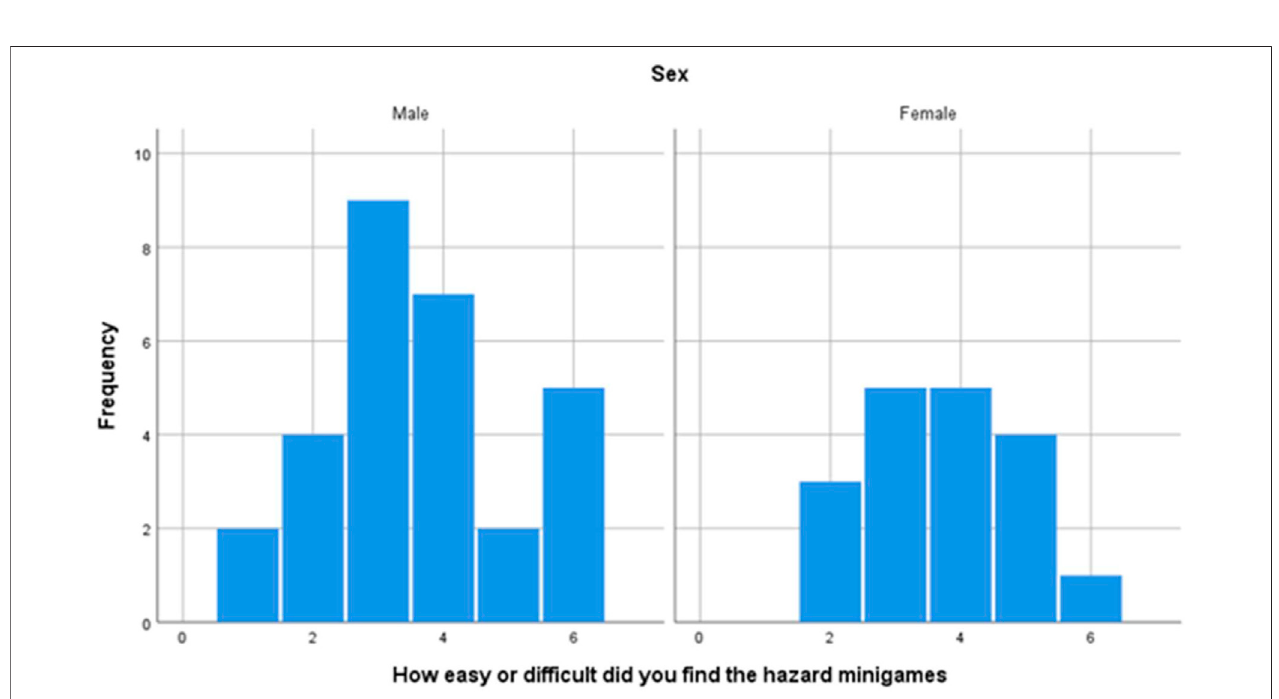
FIGURE 10 | Questionnaire participants results for how dif fi cult they found the hazard minigames.